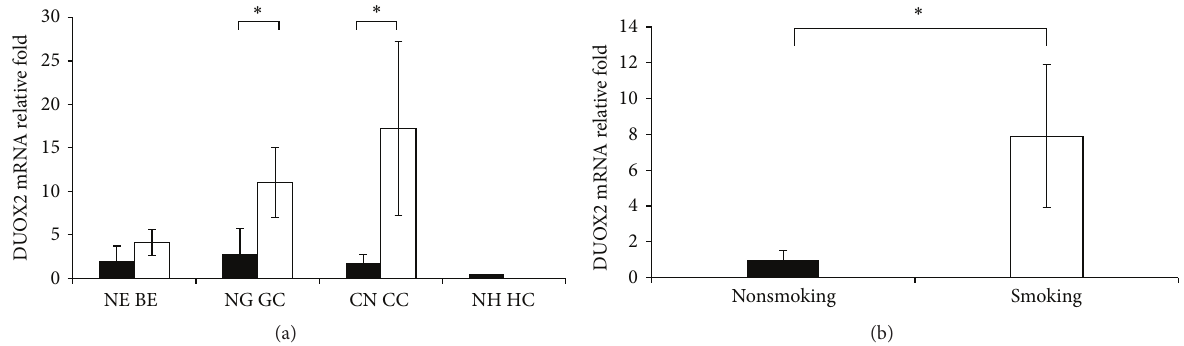
Figure 1: DUOX2 mRNA levels in Barrett esophagus, tumors of stomach, colon, and liver. (a) DUOX2 mRNA was at similar level in normal epithelium of esophagus and Barrett esophagus. The expressions of DUOX2 mRNA in gastric cancer and CRC were both significantly higher than that in each corresponding adjacent nonmalignant tissues. DUOX2 mRNA was hardly detected in hepatic carcinoma and adjacent nonmalignant liver tissue. ∗ 𝑃 < 0.05 . NE: normal esophagus; BE: Barrett esophagus; NG: adjacent nonmalignant gastric tissue; GC: gastric cancer; NC: adjacent nonmalignant colon tissue; CC: CRC; NH adjacent nonmalignant hepatic tissue; HC: hepatic carcinoma. (b) DUOX2 mRNA level in gastric carcinoma of patients with smoking history ( 𝑛 = 8 ) was 7.9-fold higher than that in patients without smoking history ( 𝑛 = 16 ). ∗ 𝑃 < 0.001 .